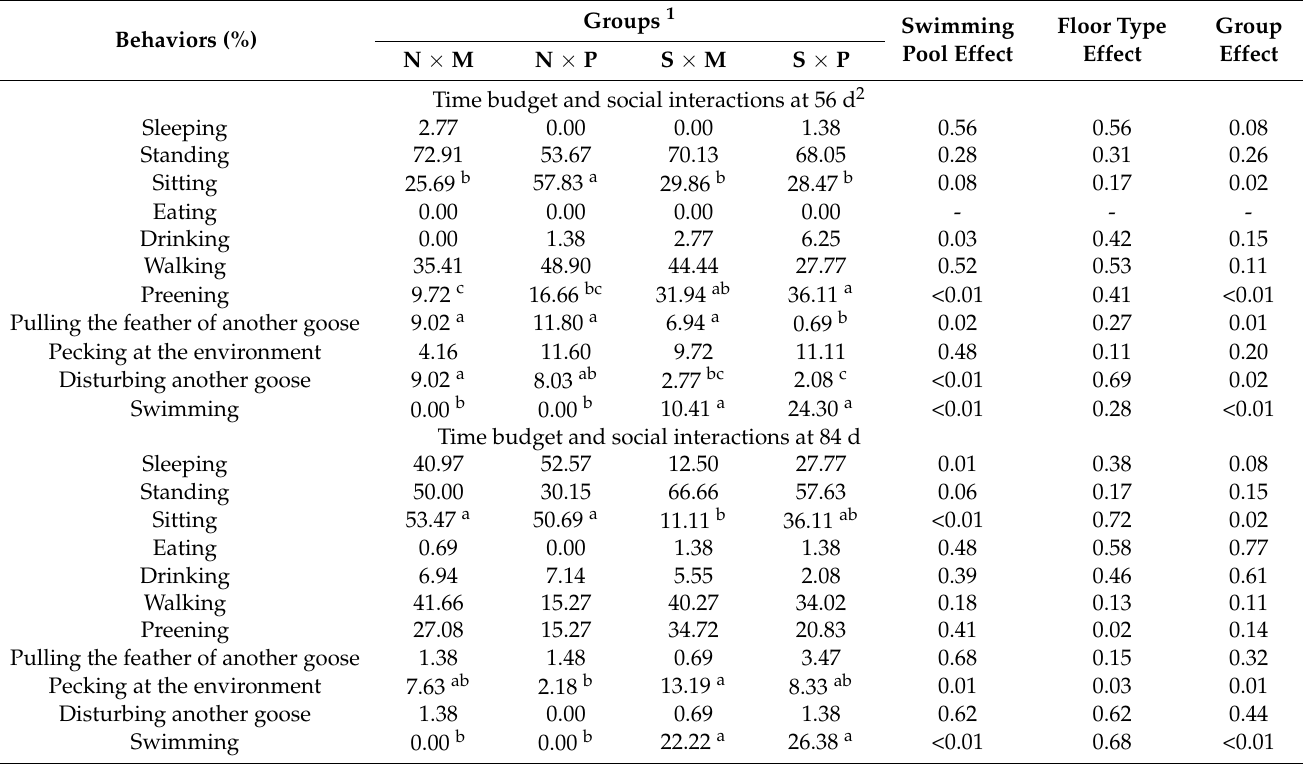
Table 4. Effects of different swimming pool conditions and floor types on average time budgets associated with the behaviors and social interactions of White Roman geese at different ages, recorded over a total of three daily scans of 2 min each per pen (percentage of geese expressing each